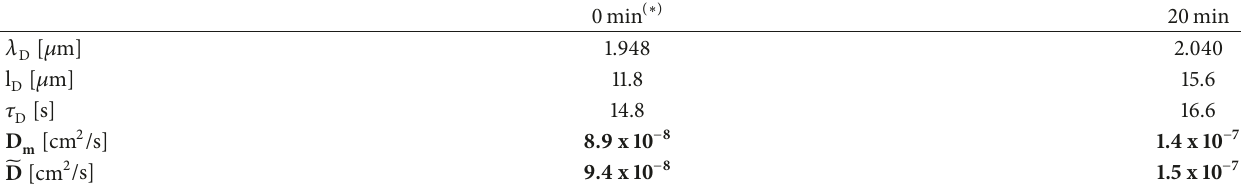
Table 1: Diffusion coefficient of ionic mobility and ammonia in SZ (d = 0.8 mm) at 383 K.